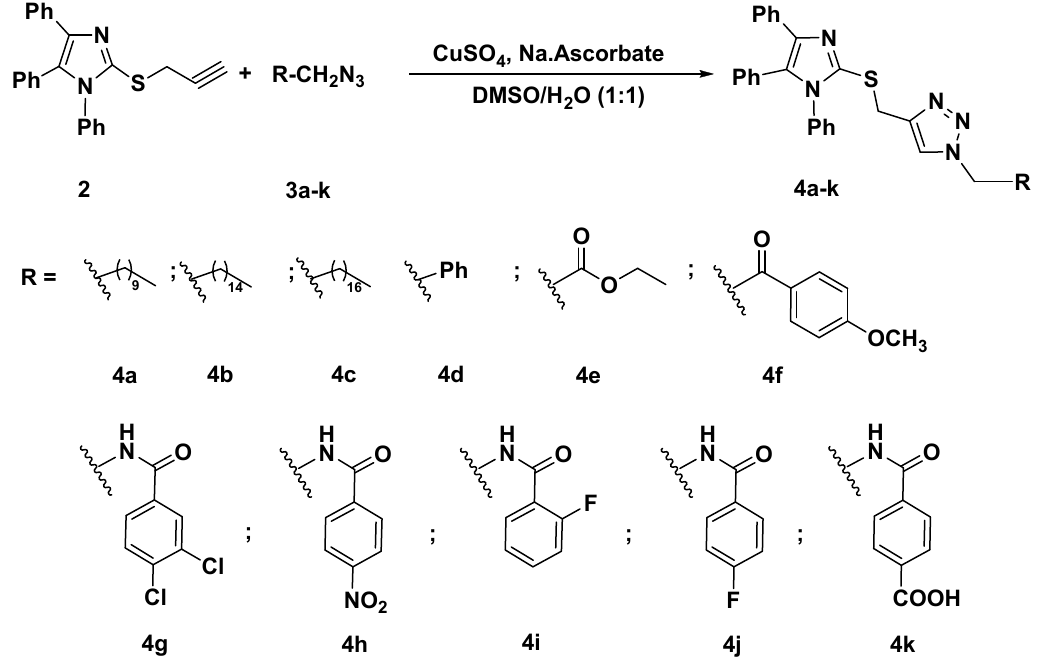
Scheme 2. Click synthesis of imidazole-1,2,3-triazole hybrids carrying un/functionalized alkyl and/or phenyl acetamide side chain 4a–k .